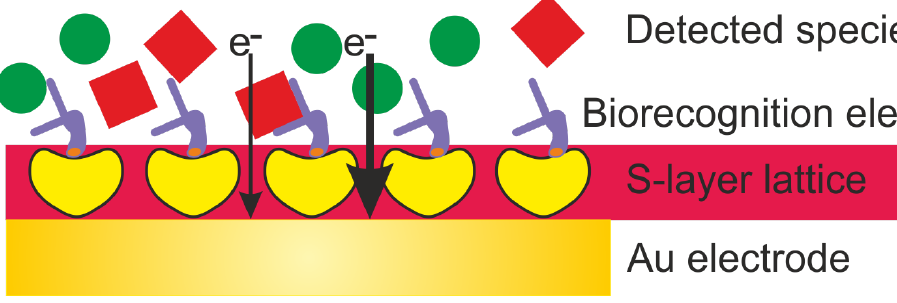
Figure 2. Schematic drawing (not drawn to scale) of an electrochemical biosensor with an S-layer lattice as intermediate layer for linking biorecognition elements to the Au (gold) electrode surfaces.